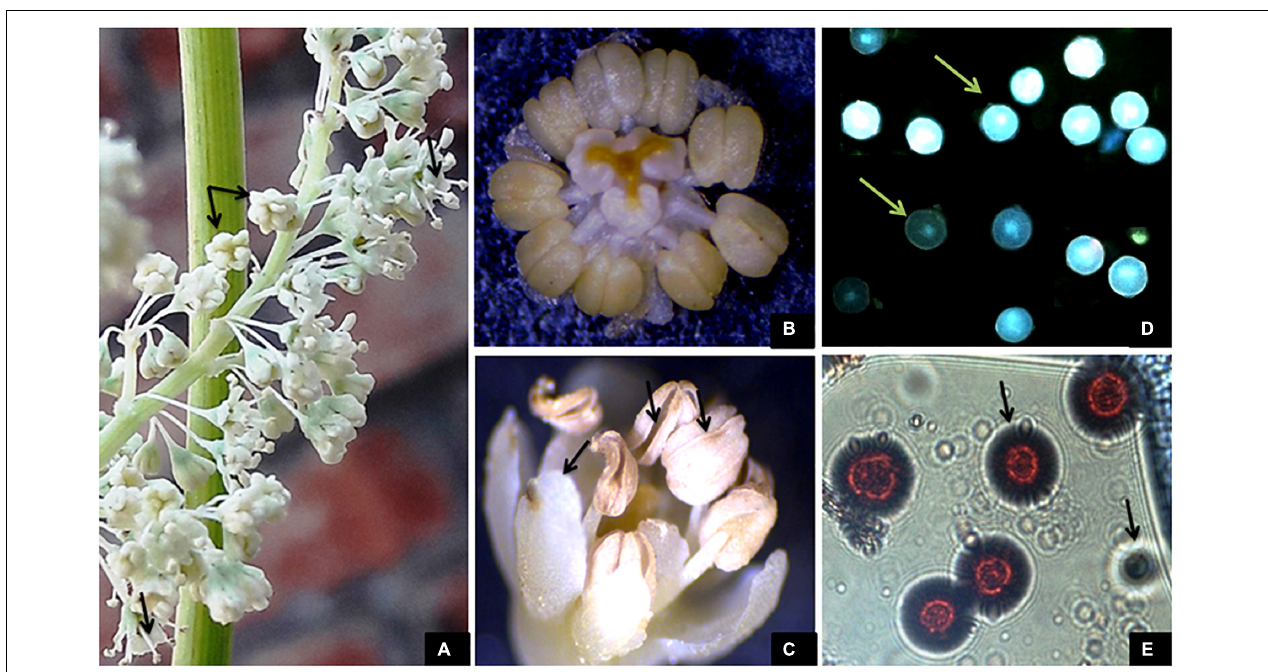
FIGURE 3 | (A) Flower anthesis and outward movement of stamens taking anthers away from the stigma. (B) Hermaphrodite flower with 9 bithecous anthers and incurved stigmas. (C) Post-pollination incurved movement of stamens and petals and anther dehiscence. (D,E) Viable and non-viable pollen grains observed at 40 × and 100 ×